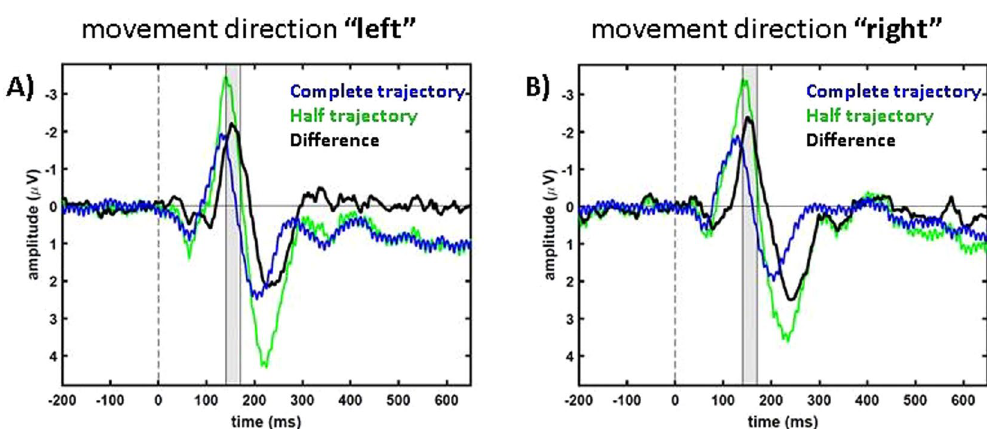
Figure 6. Signals with respect to the motion directions of frontal electrodes in condition “central”. In blue data of the second motion phase of “complete trajectory” trials are presented, in green data of “half trajectory, appear” trials and in black the differences (“complete trajectory”, 2. Phase of standard trials subtracted from “half trajectory, appear” data) are shown. ( A ) shows condition “left” and ( B ) condition “right”. In ( A ) data pooled over electrodes over the right hemisphere (F4, FC2, FC6) is presented, in ( B ) data pooled over electrodes over the left hemisphere (F3, FC1, FC5). The gray area marks the times that were analyzed for this electrode cluster, i.e. 140 ms to 170